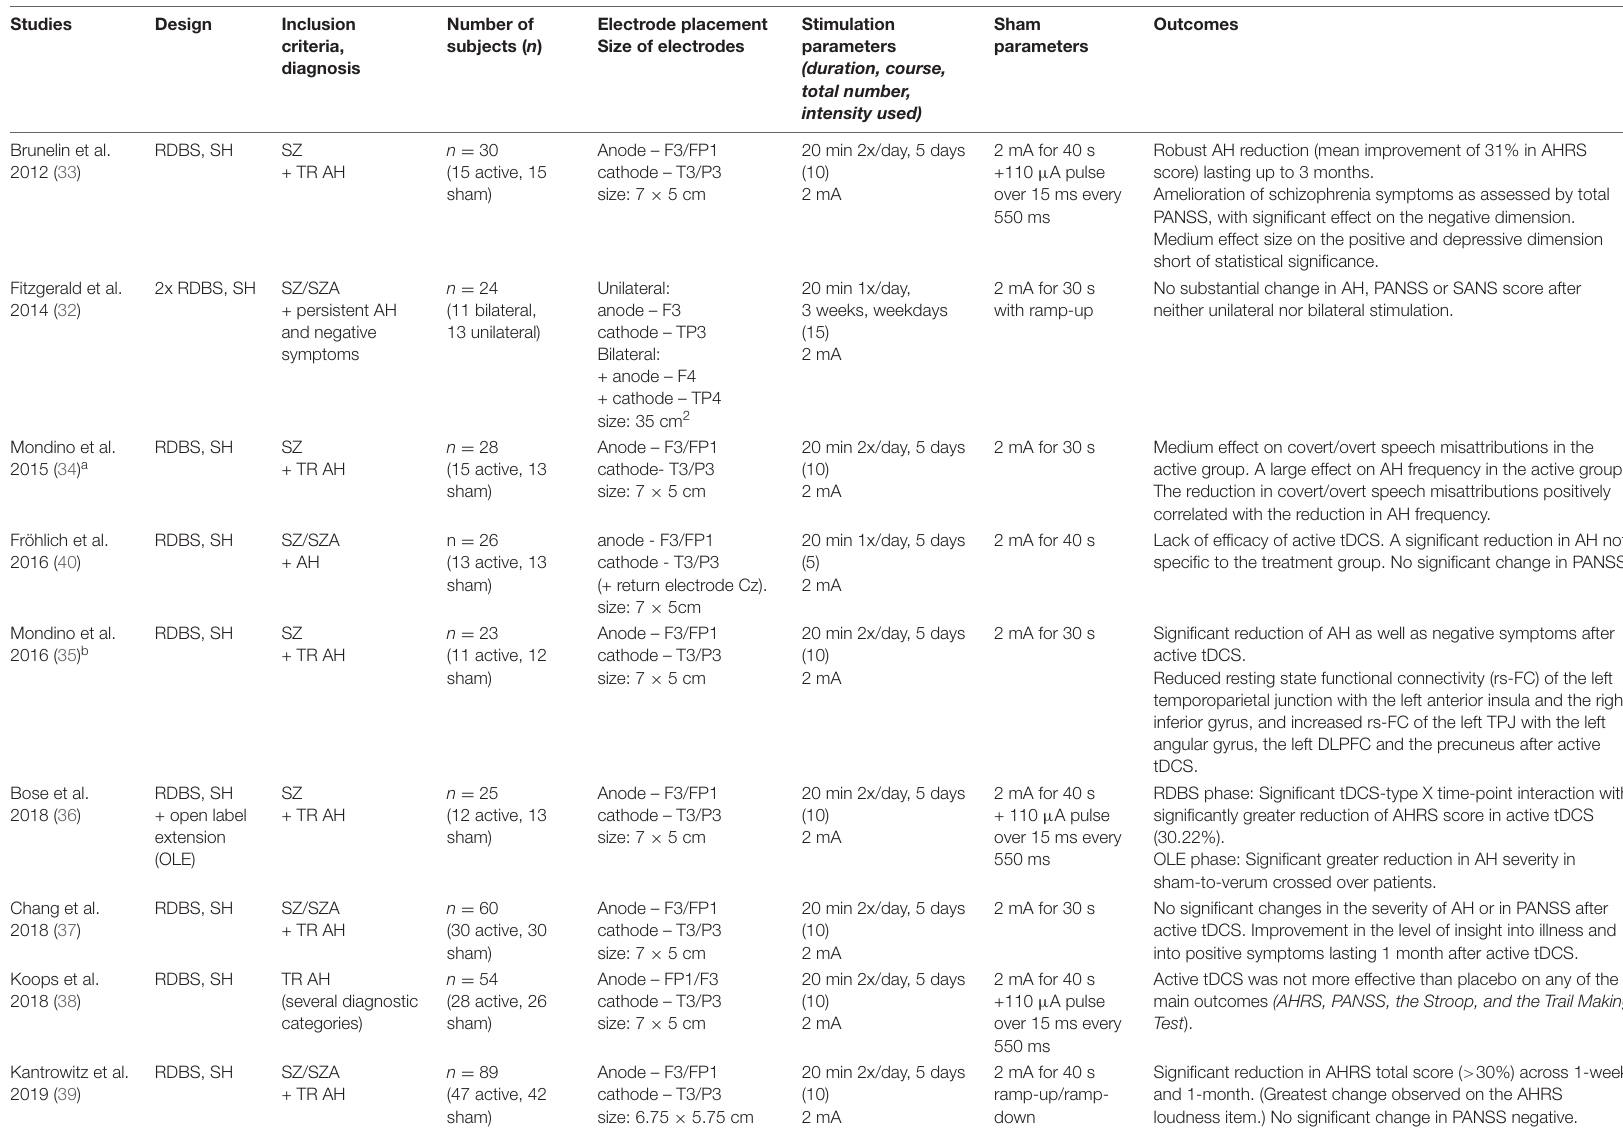
TABLE 1 | Effects of tDCS on positive